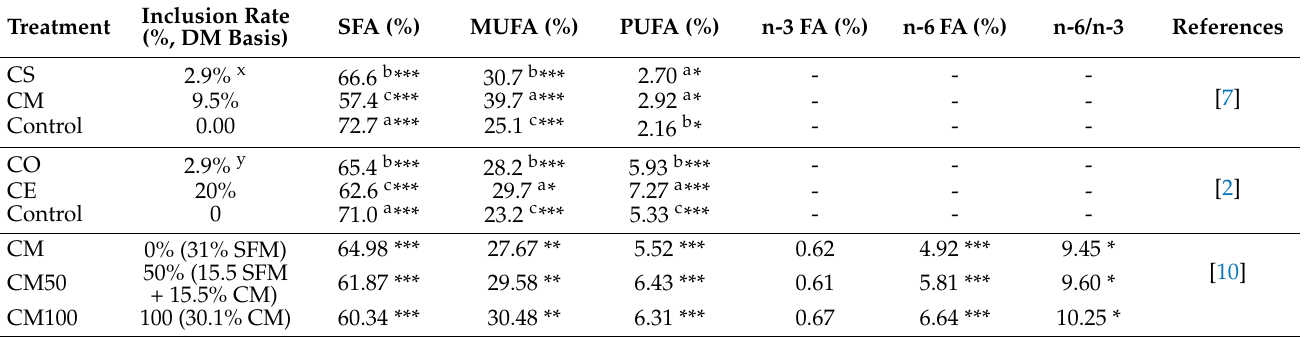
Table 9. Effect of Camelina seed and derivatives on the composition of milk fatty acid composition in dairy Cow’s milk fat.